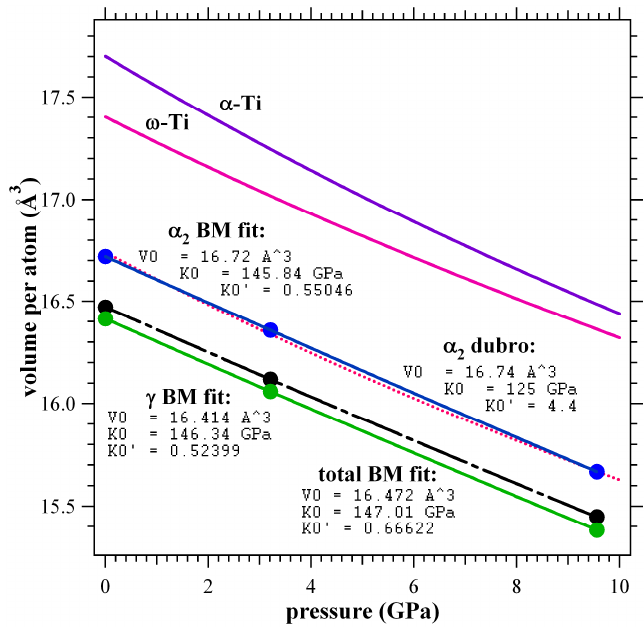
Figure 9. Atomic volumetric compression behavior of the investigated composition Ti ‐ 45Al ‐ 7.5Nb ‐ 0.25C with Birch–Murnaghan fits (experimental dots with continuous lines), as compared to α 2 ‐ single ‐ phase compression, and α‐ and ω‐ titanium, reported by Dubrovinskaia [59] and Errandonea [48], respectively. Table 1. Compilation of experimental lattice parameters a 0 and c 0 under ambient conditions, as well as the derived quantities; their axis ratios and volume per atom V A , compression parameters K 0 , K 0 ’ (first three rows) and data from the literature. The α‐ phase lattice is given in α 2 cell notation, and therefore, 2 c / a is noted. The first V A column is computed from a 0 and c 0 , while the second results are from the fit of pressure data to Equation (6). The original data of Yeoh’s publication [31] has been re ‐ visited to extract the listed values at 300 K. Literature values are reported from their experimental findings, in addition to Ghosh’s first ‐ principles study [61]. Further listed references are Dubrovinskaia [59], Errandonea [48], Asta [60], Zhang [55], JCPDS [56], and Menon [78]. a , c in (Å); V in (Å 3 ); K 0 in (GPa).